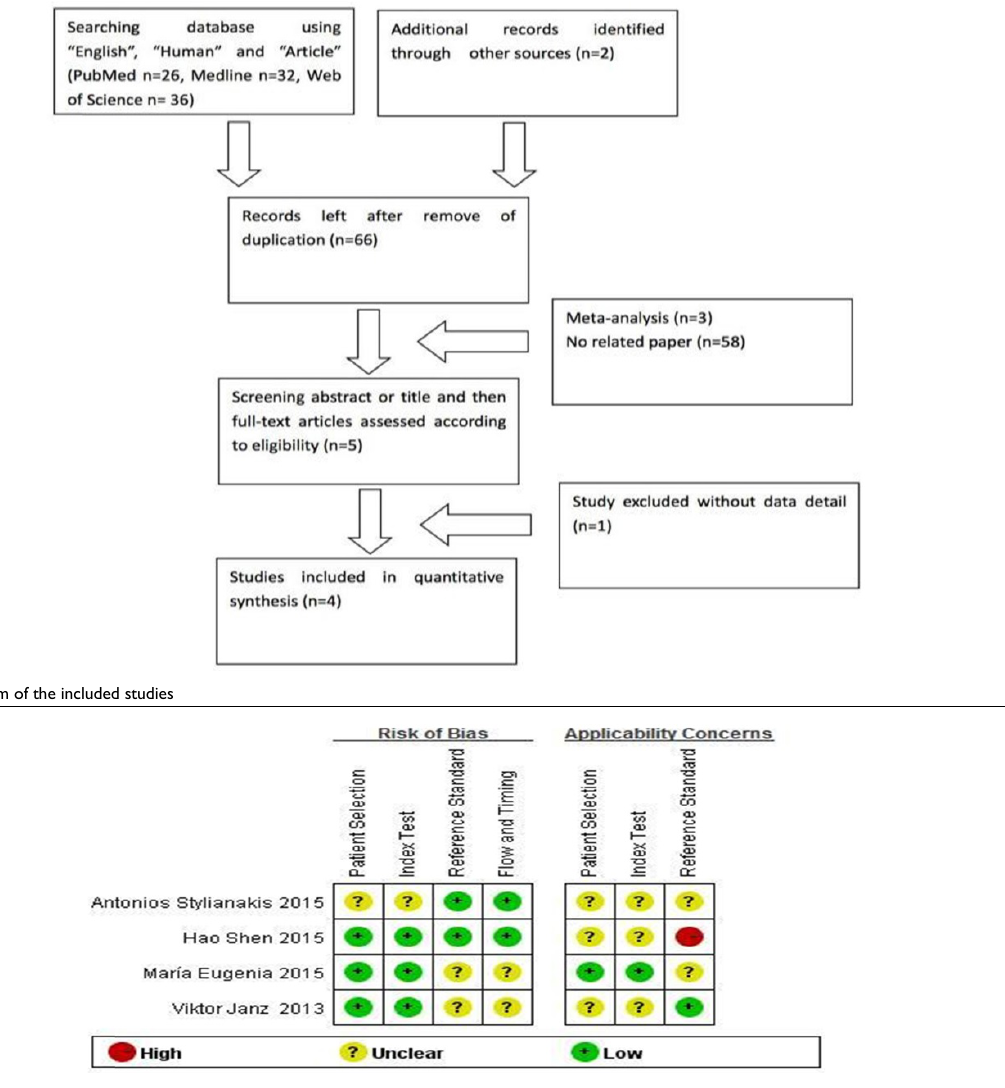
Figure 1. Flow diagram of the included studies